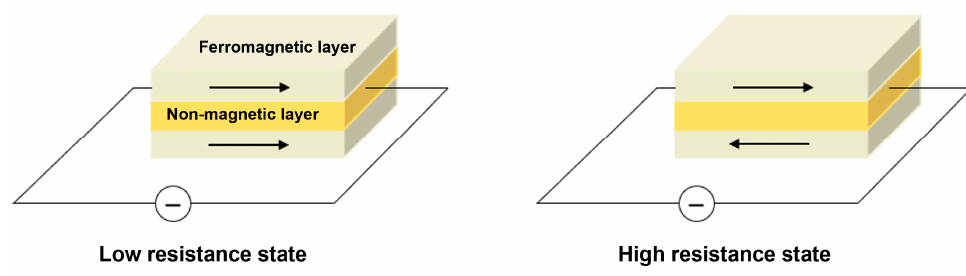
Figure 7. Working principles of GMR sensor.